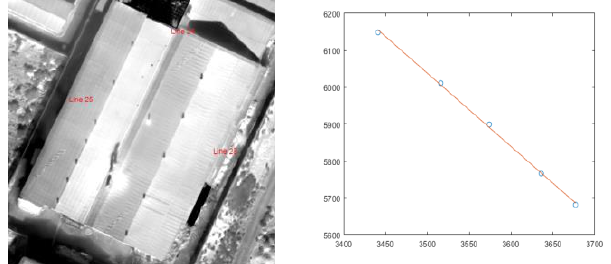
Figure 8. Location of line number 23 (left) and standard deviation chart for line number 23 (right) Moreover, the value of the standard deviation for line number 1 shows that this line is well reconstructed (Figure 9).